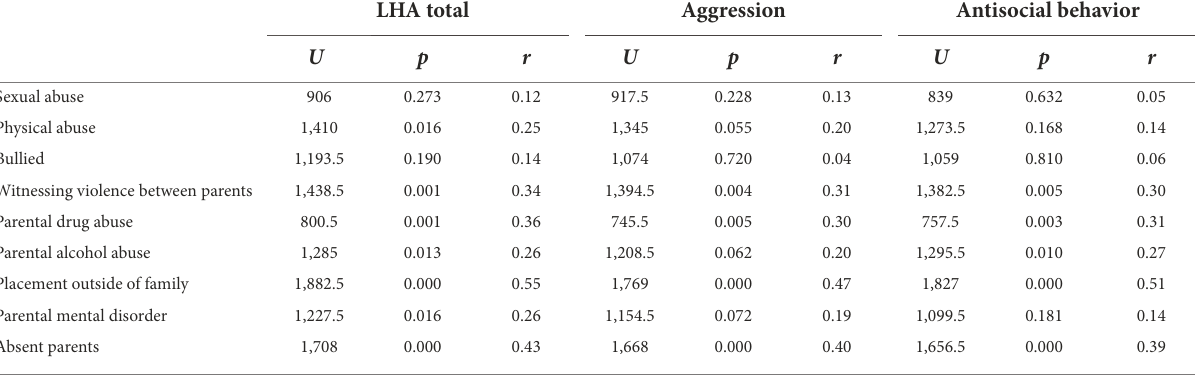
Table 2 Mann–Whitney U test investigating differences in LHA total score and subscales Aggression and Antisocial Behavior on the nine ACE-items included in our clinically assessed ACE